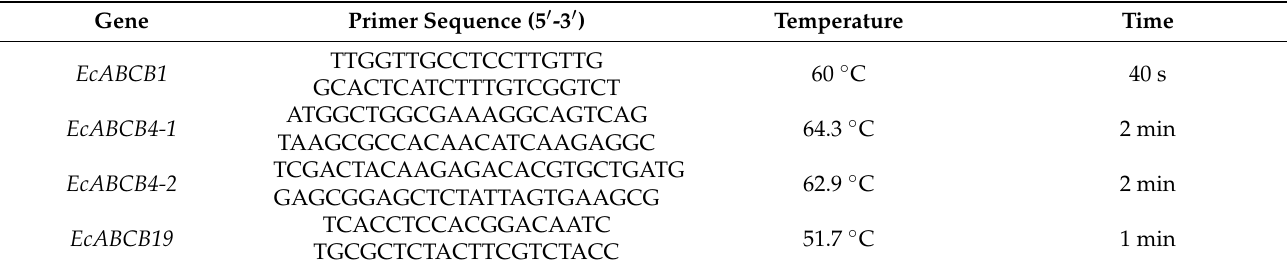
Table 1. The primer sequences for amplification of EcABCBs genes.